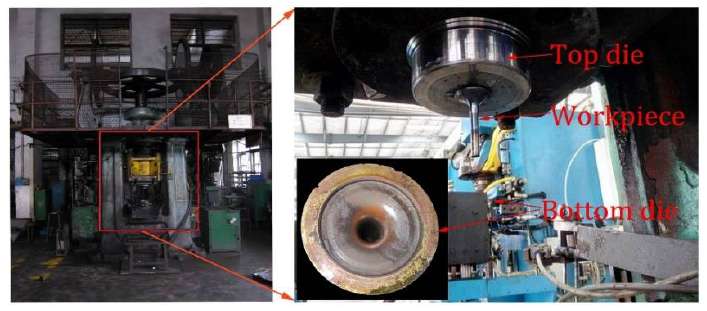
Figure 7. Hot forging machine for valves.